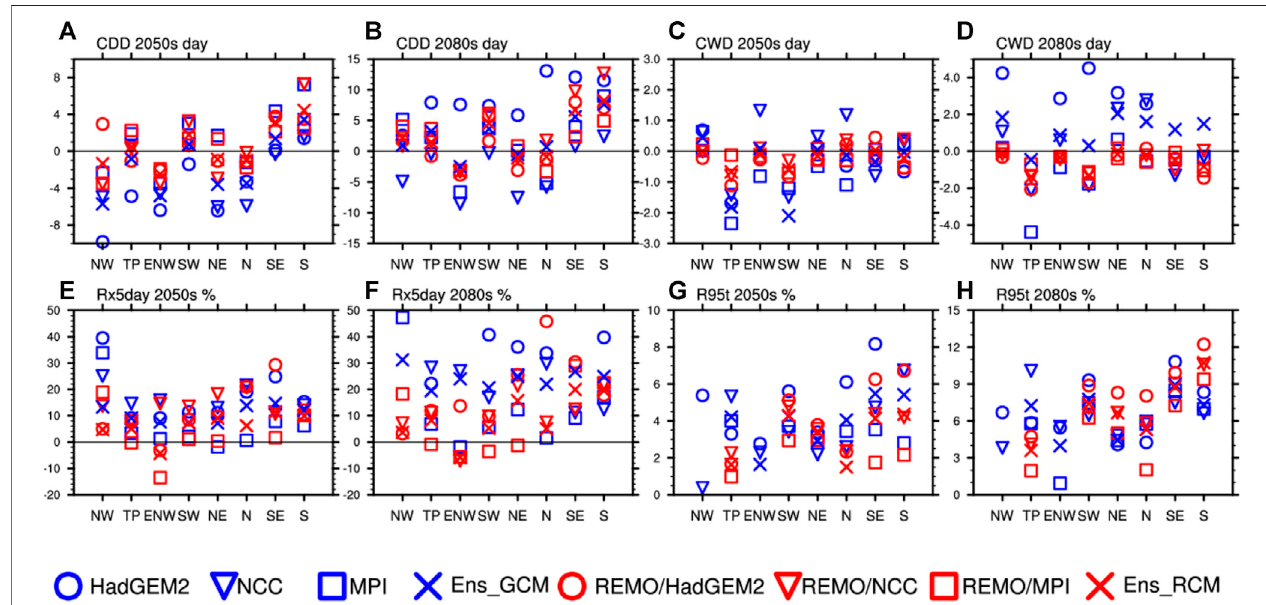
FIGURE10| Thechangesintheextremeindicesinthemid21stcentury(2036 – 2065,2050s)andthelate21stcentury(2066 – 2095,2080s)relativetothehistorical period in the eight sub-regions.